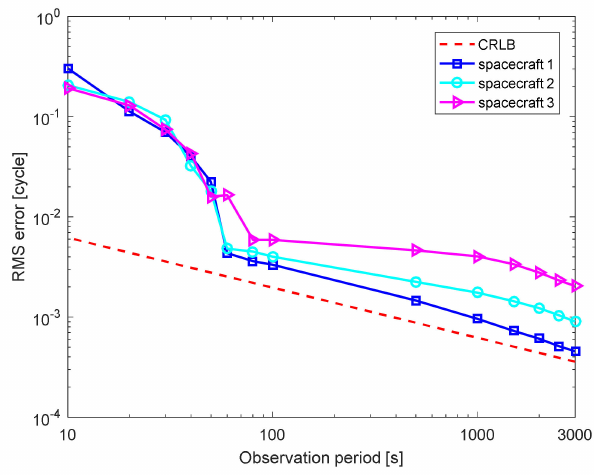
Figure 7. Pulse phase estimation results for three